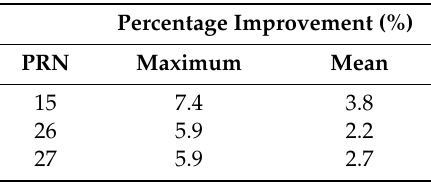
Figure 11. SNR comparison of the MND and the TSMA within the small-N region (shaded area) for the early detection case (ANHN station, PRN15). ( a ) SNR of the MND and the TSMA, ( b ) SNR improvement of the MND against the TSMA. Table 4. The SNR improvement of the MND against the TSMA within the small-N region (the average values of 45 NGII stations are used for analysis).